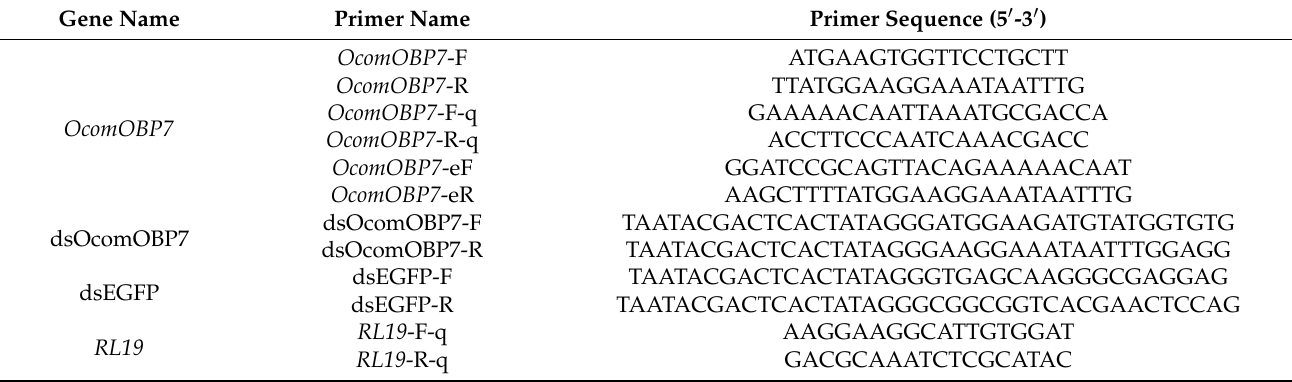
Table 1. The primer sequence of OcomOBP7 for cloning, RT-qPCR, and